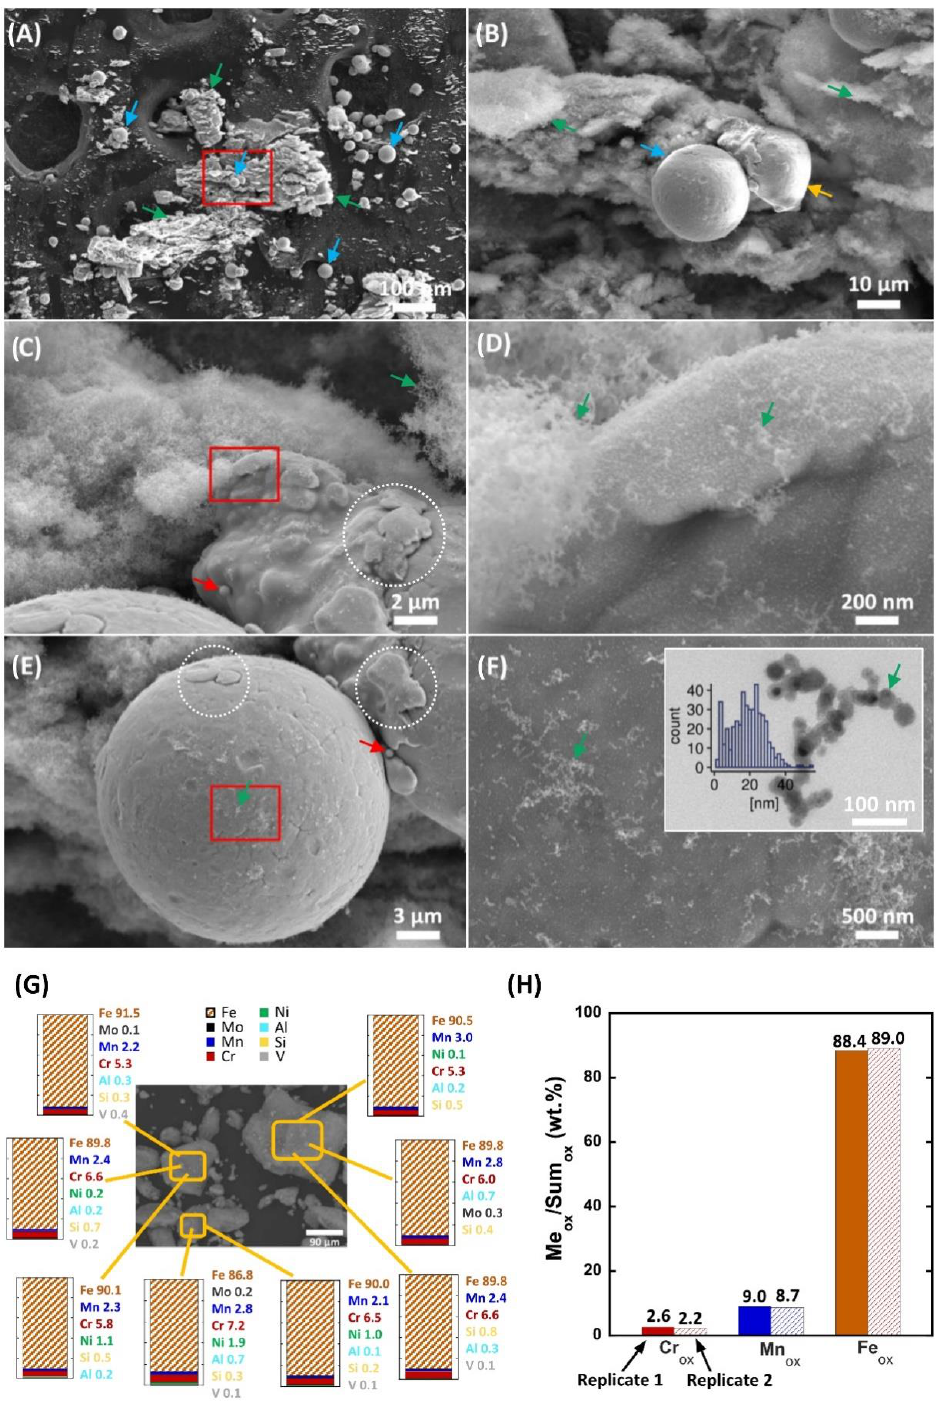
Figure 2. Physicochemical characterization of the (nano)particles unintentionally emitted at the metal AM occupational settings (AMPs ). ( A – F ) Scanning electron microscopy (SEM) images demonstrating the size and shape characteristics of the collected AMPs. The blue arrows indicate the spherical micron-sized particles (possibly the feedstock material, based on size/shape/chemical composition), the yellow arrow highlights the micron-sized particles with an altered shape, and the green arrows indicate the large and irregularly shaped particle clusters. The red rectangular spaces in ( A ), ( C ), and ( E ) are magnified in ( B ), ( D ), and ( F ). The red arrows in ( C ) and ( E ) show the